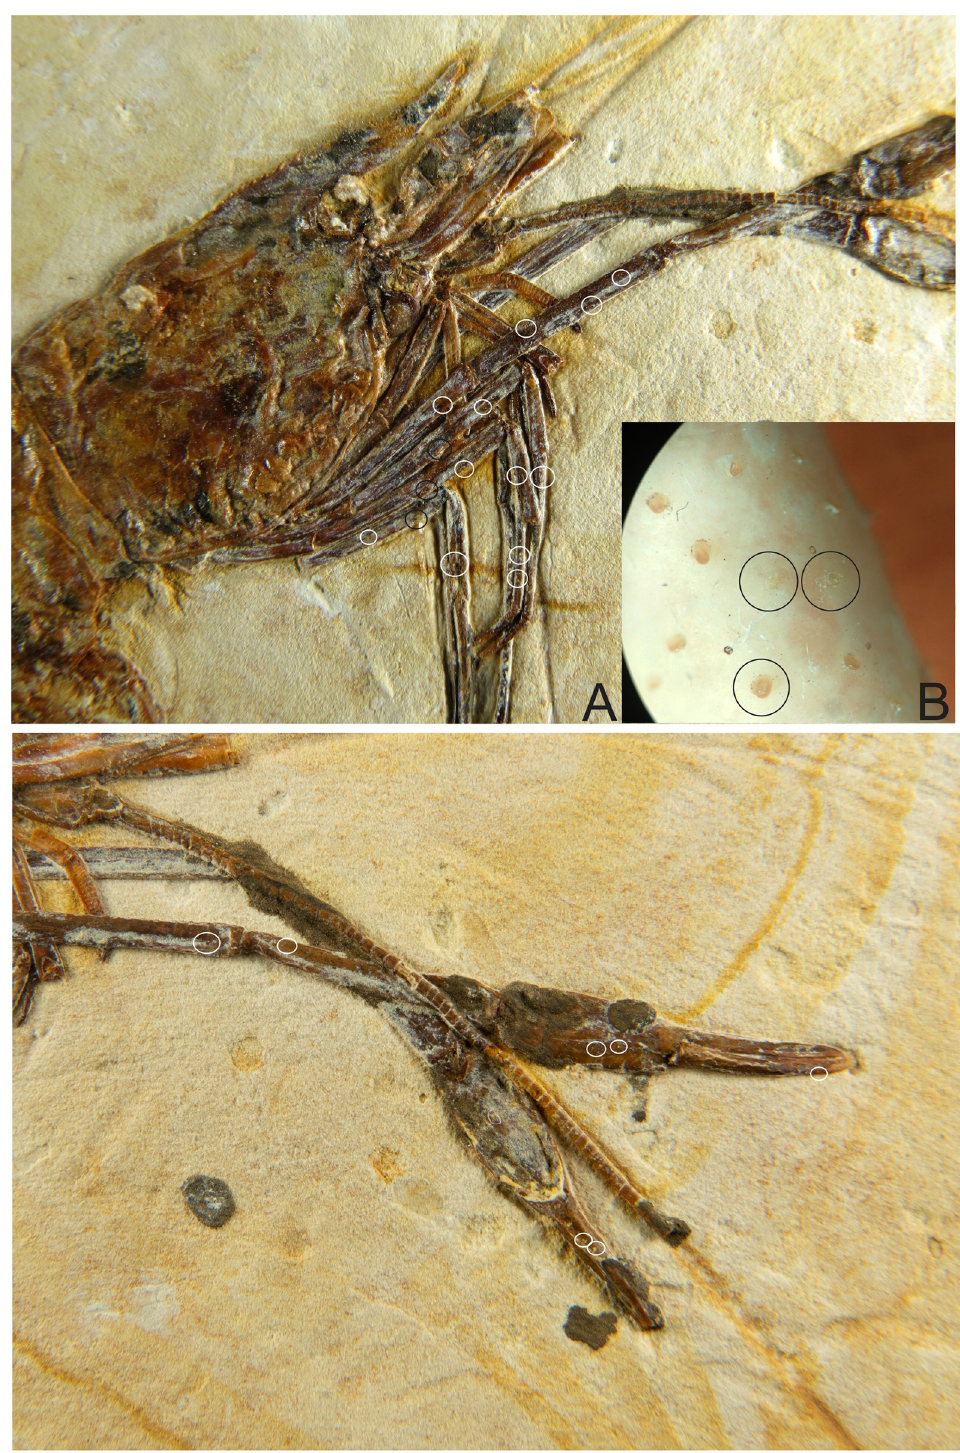
Fig 7. 1673/LPU. (A) Detail of the pereiopods spines (black circle) and tubercles (white circle). (B) Detail of tubercles in existing caridean, when the tubercle is broken stay one hole in place of the tubercles (hole in detail of two black circles on the side by side). This hole can be filled by sediment during fossilization. (C) white circle is the detail of the tubercles in the second pereiopod (P2).